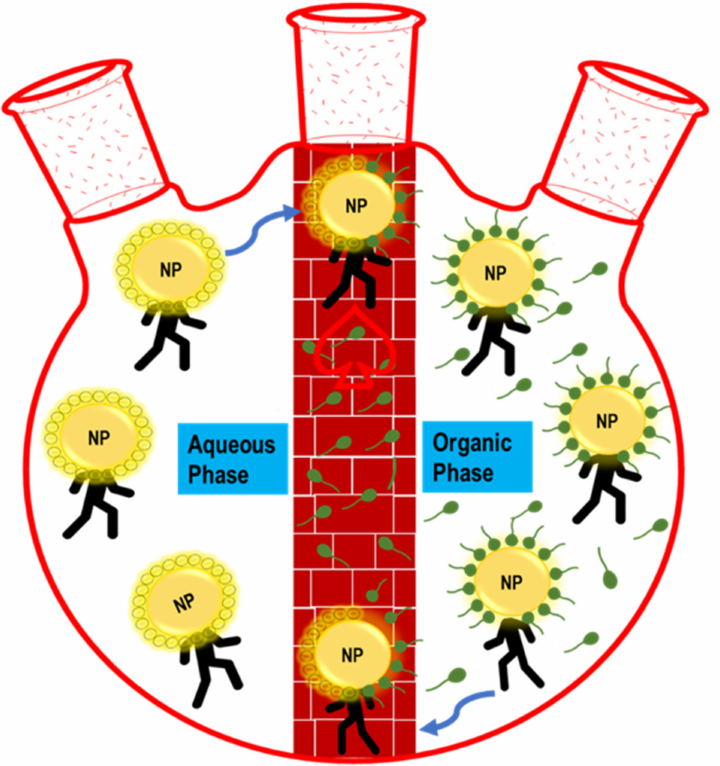
Figure 2. Schematic representation of phase transfer via a ligand-exchange reaction. In the figure, the abbreviation “NP” means